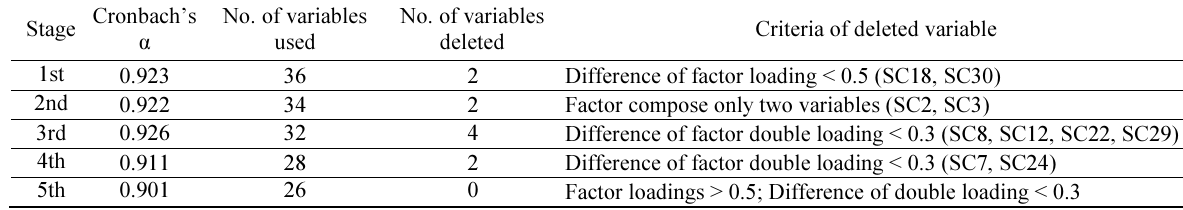
Table 4. Summary procedure of factor analysis for deleted variables Cronbach’s Stage